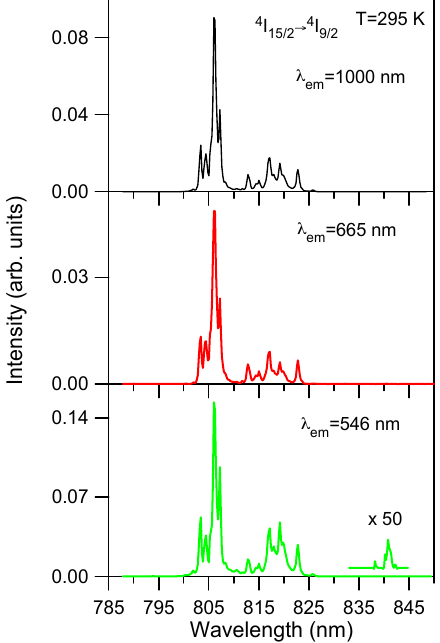
Figure 4. Excitation spectra of the upconverted emissions from levels 4 S 3/2 (546 nm) and 4 F 9/2 (665 nm) corrected for the spectral variation of the laser intensity. The ground state excitation spectrum corresponding to 4 I 11/2 → 4 I 15/2 transition is also included for comparison.